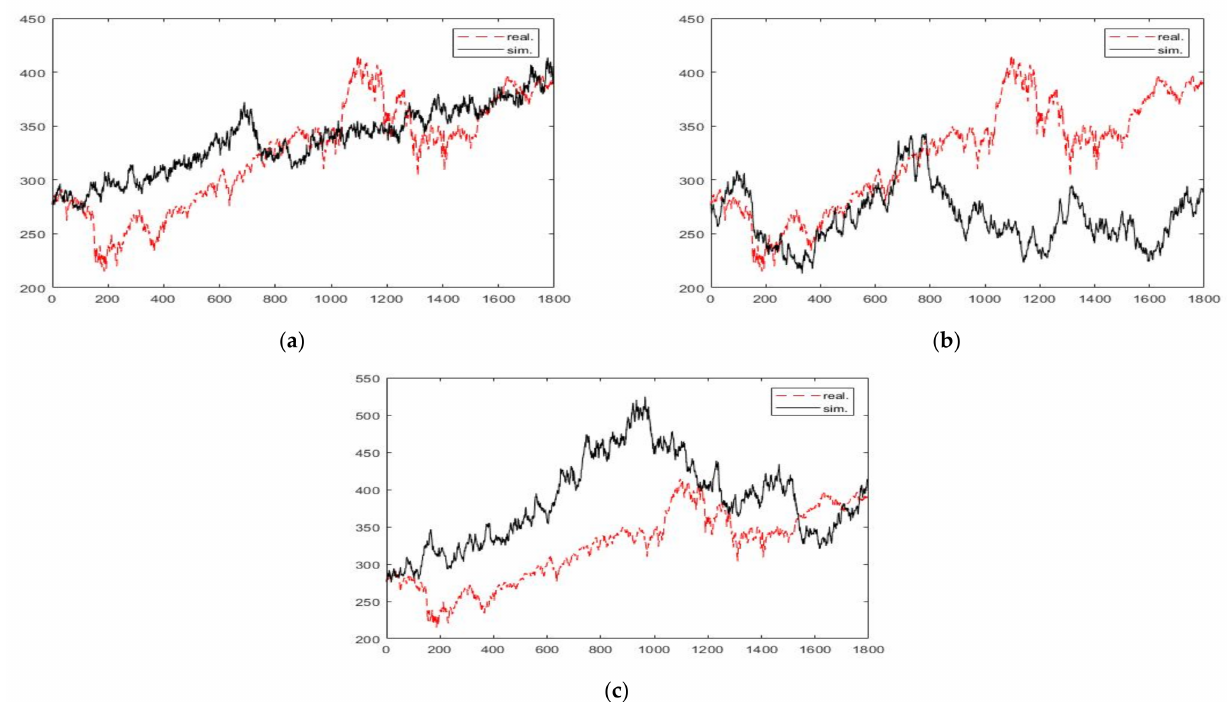
Figure 7. Simulation results using GBM (7-year period): ( a ) Hurst PE, ( b ) Hurst RS, ( c ) Hurst 0.5.